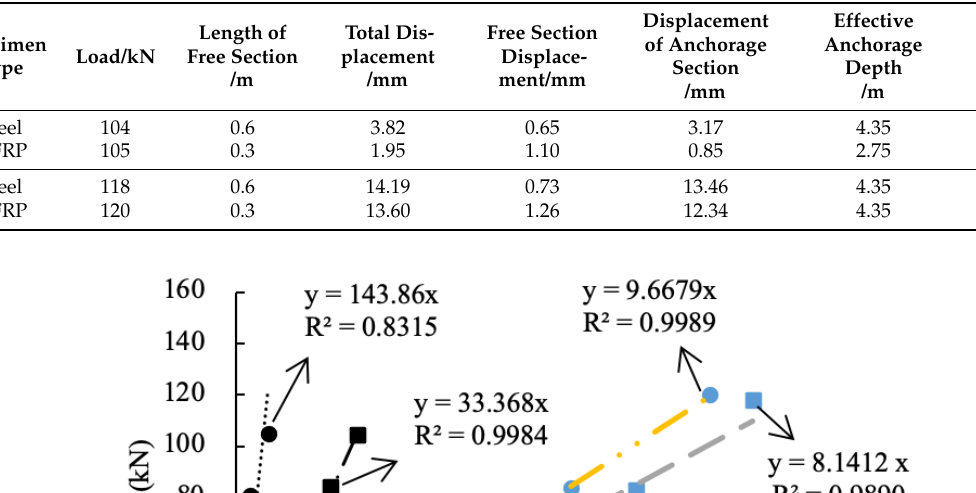
Table 7. Statistics of relative difference of various indexes.